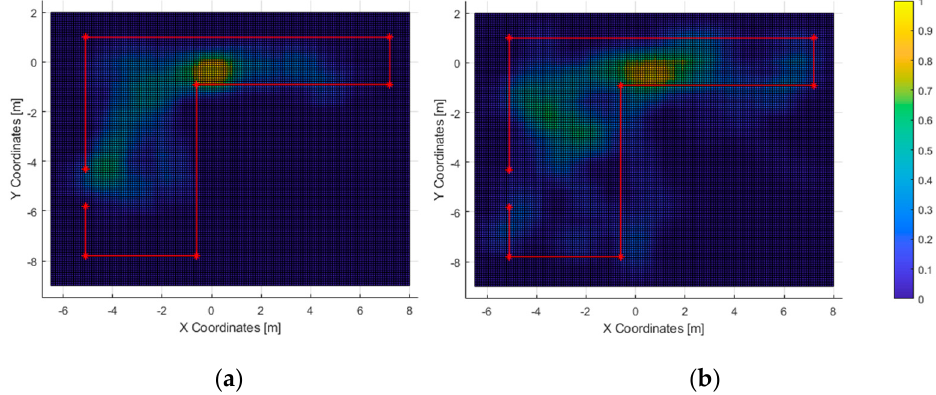
Figure 13. Test 2—Path heatmaps of those who passed the test ( a ) and those who did not ( b ). Spatial resolution: 5 cm. Low-pass FIR: 25 × 25 cell flat impulse response.